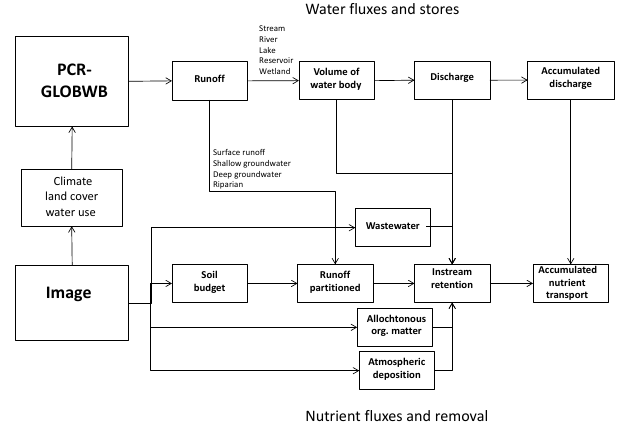
Figure 2. Scheme of the model framework with PCR-GLOBWB and IMAGE and the data flows between the